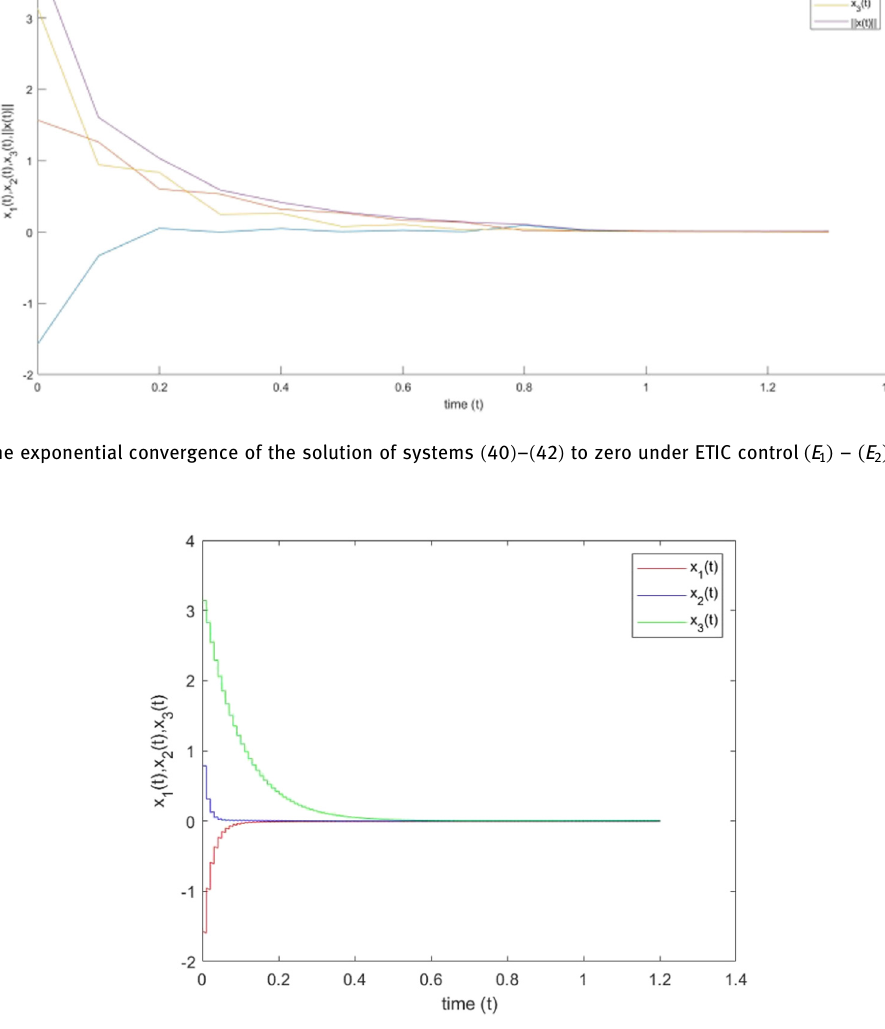
Figure 4: The exponential convergence of the solution of systems ( 40 ) – ( 42 ) to zero under TTIC